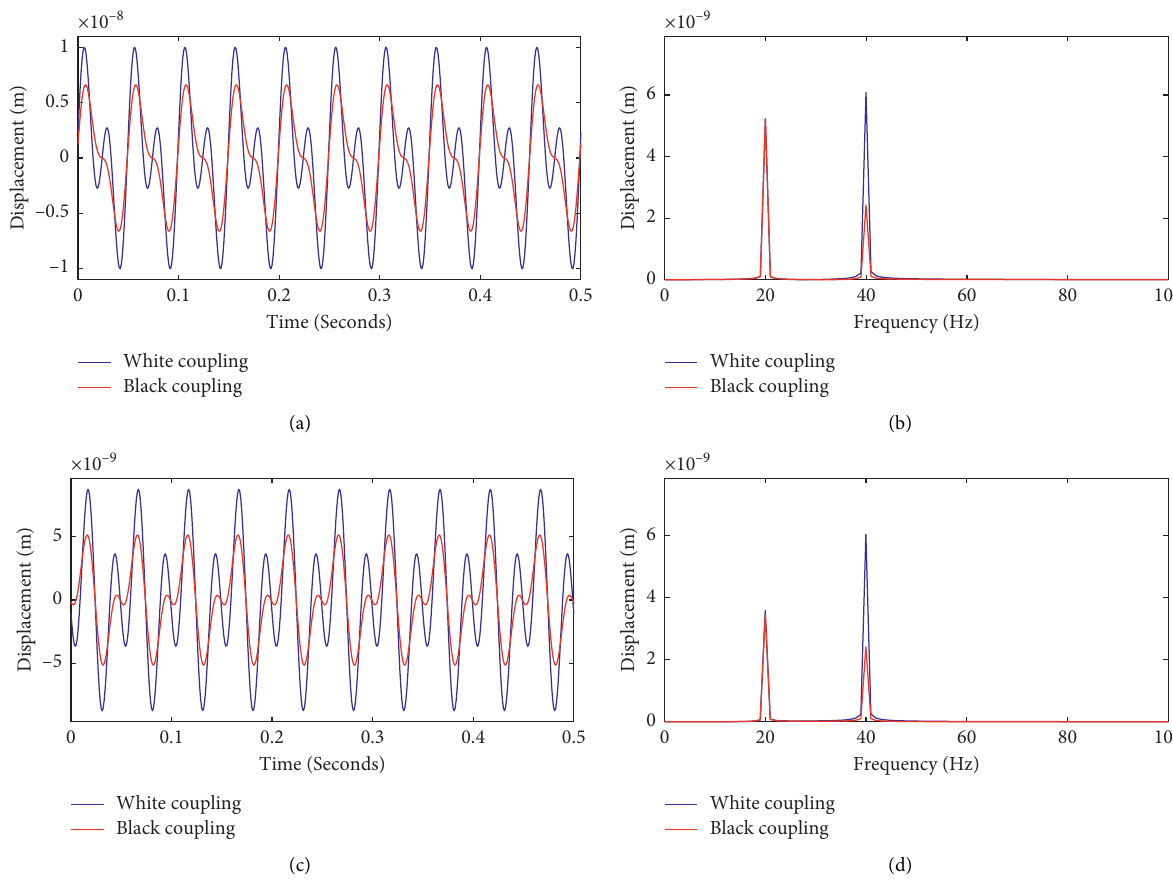
Figure 23: Effects of changing the coupling type in the x direction for a system with imbalance and parallel misalignment. (a) Time response of x1. (b) Frequency response of x1. (c) Time response of x2. (d) Frequency response of